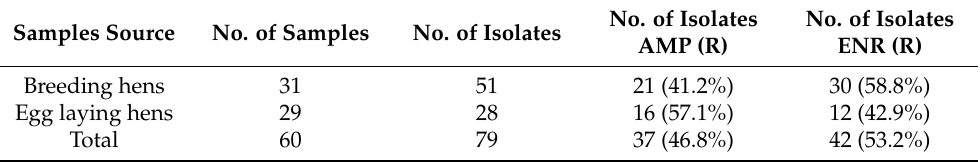
No. of Isolates No. of Isolates AMP (R) ENR (R)